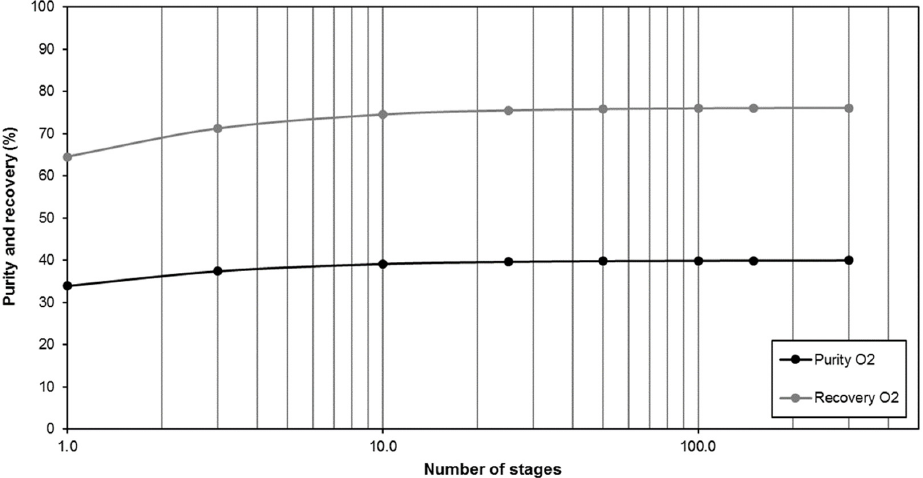
Figure 2. Evolution of the recovery and purity of O 2 (permeate) as function of the modelled number of cells considered in the membrane module.